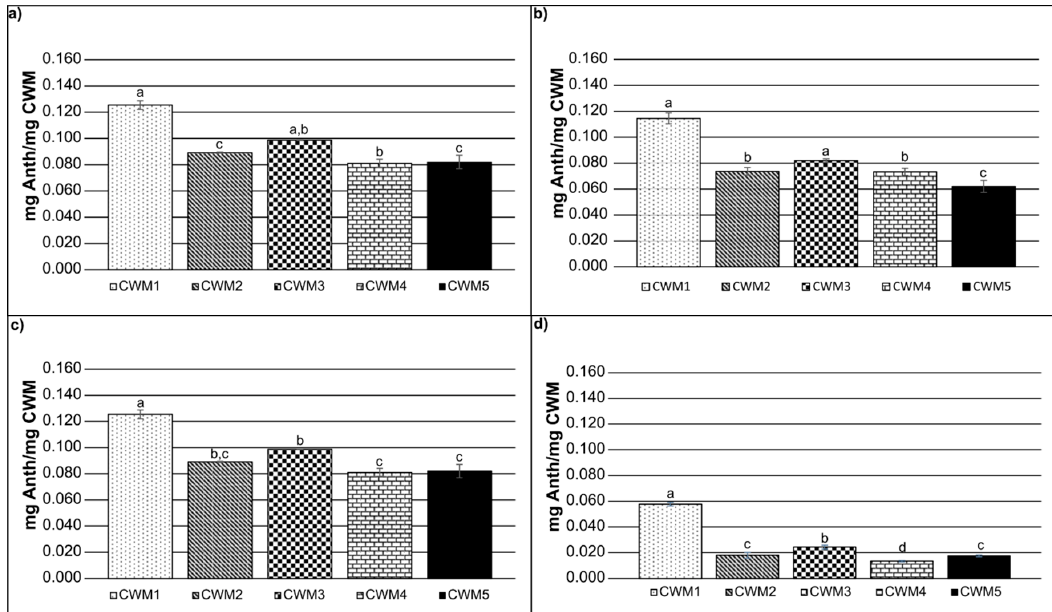
Figure 2. Anthocyanin adsorption values reached after 120 min for: ( a ) 0% EtOH and 15 °C, ( b ) 15% EtOH and 15 °C, ( c ) 0% EtOH and 30 °C, ( d ) 15% EtOH and 30 °C; Error bars represent the standard deviation of replicate measurements ( n = 3). Significance was determined using analysis of variance (ANOVA).